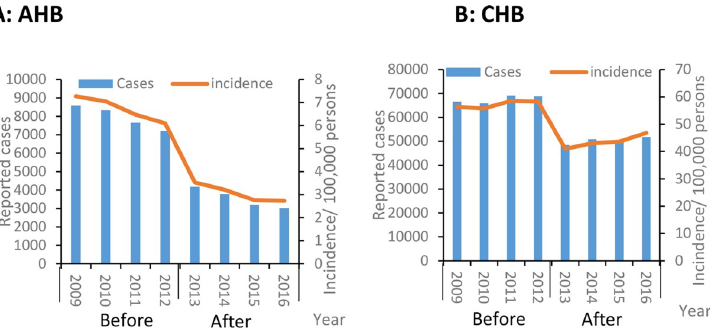
Fig 3. Reported cases and incidence of hepatitis B (acute and chronic) before and after sentinel surveillance, China, 2009–2016. Reported cases and incidence of acute hepatitis B. (B) Reported cases and incidence of chronic hepatitis